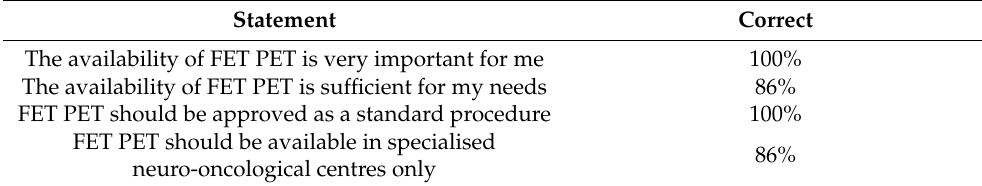
Table 4. Referrers’ rating on the general availability of FET